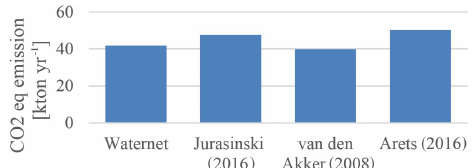
Figure 4. Estimation of total GHG emissions in Groot-Wilnis Vinkeveen and surrounding area (for different methods: Table